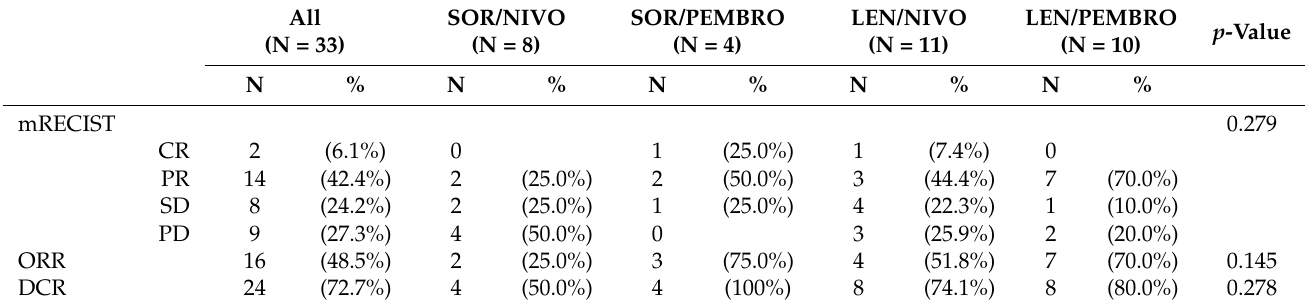
Table 2. Best radiological responses.